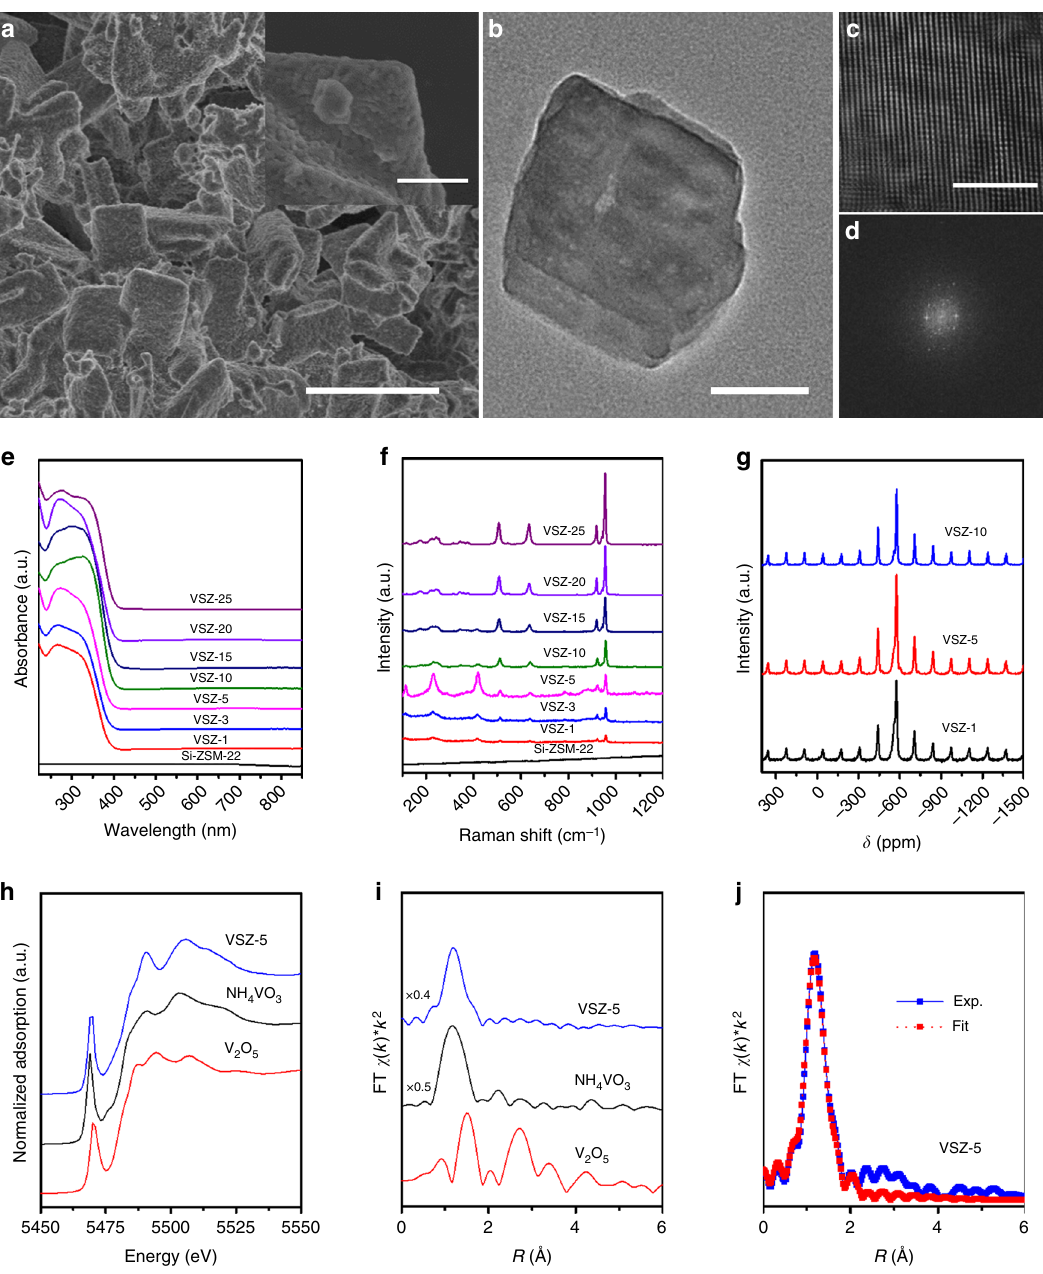
Fig. 2 Structure characterization. a SEM and b – d TEM images of VSZ-5; e UV-vis, f Raman, and g 51 V MAS NMR spectra of VSZ- n samples; h X-ray absorption near edge structure (XANES) of V K-edge for VSZ-5 with the reference materials NH 4 VO 3 and V 2 O 5 ; i The k 2 -weighted Fourier transform spectra derived from EXAFS for VSZ-5 with the reference materials NH 4 VO 3 and V 2 O 5 ; j FT-EXAFS curves between the experimental data and the fi t. Scale bars, 10 μ m and insert diagram of 2 μ m ( a ), 50 nm ( b ), and 5 nm ( c recovered and reused. In the six-run recycling tests, stable activity V content and large surface area) within a short reaction time (Fig. 3a, b). Selective ring hydroxylation of toluene was also achieved over VSZ- n to produce cresols with almost equal o - and p -product (Fig. 3d and Supplementary Table 5). VSZ-5 gave the highest cresols yield of 26.2% and selectivity of 91.8% (Fig. 3d, e), rendering an ef fi cient heterogeneous catalyst for the highly chemo-selective oxidation of toluene to cresols. A hot- fi ltration test was performed by fi ltrating the solid catalyst after the addi- tion of H 2 SO 4 . The fi ltrate solution is inactive in promoting benzene to phenol, verifying that the hydroxylation process is intrinsically heterogeneous and excludes the contribution of the potentially leached V species. After reaction, VSZ-5 can be facilely